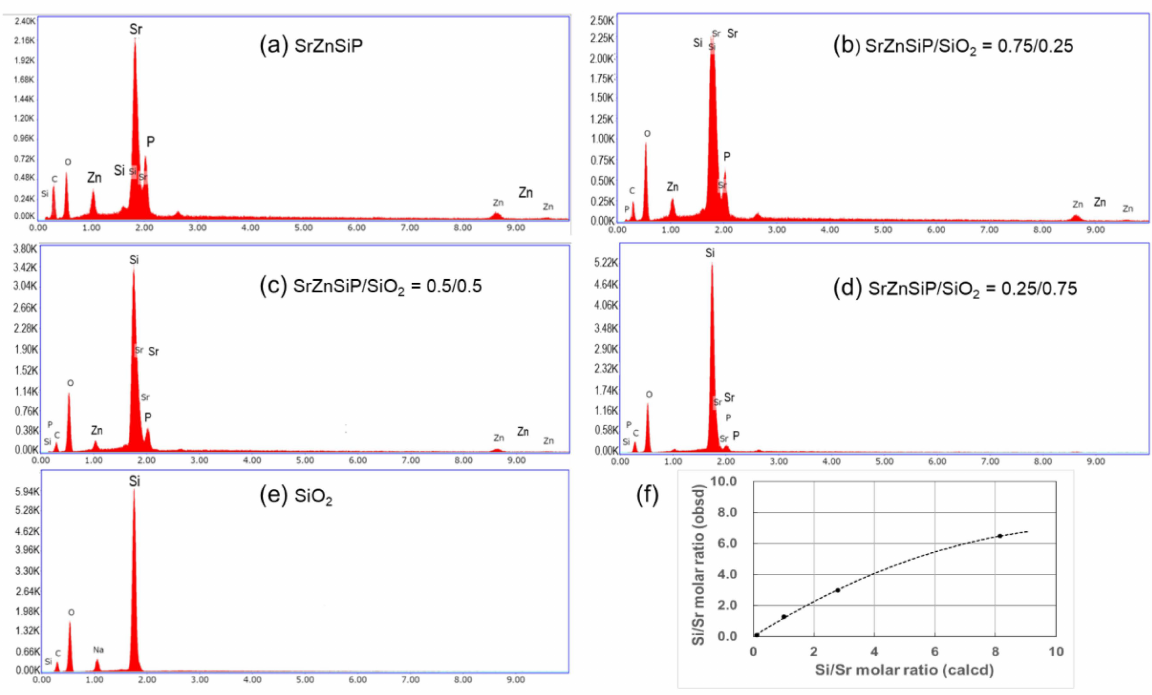
Figure 8. Elemental analyses by SEM/EDS on the coating surfaces of ( a ) SrZnSiP; ( b ) mixture of SrZnSiP and SiO 2 (0.75/0.25); ( c ) mixture of SrZnSiP and SiO 2 (0.5/0.5); ( d ) mixture of SrZnSiP and SiO 2 (0.25/0.75); and ( e ) SiO 2 . ( f ) Plot of observed Si/Sr molar ratios shown in ( a – d ) vs. those of the calculated